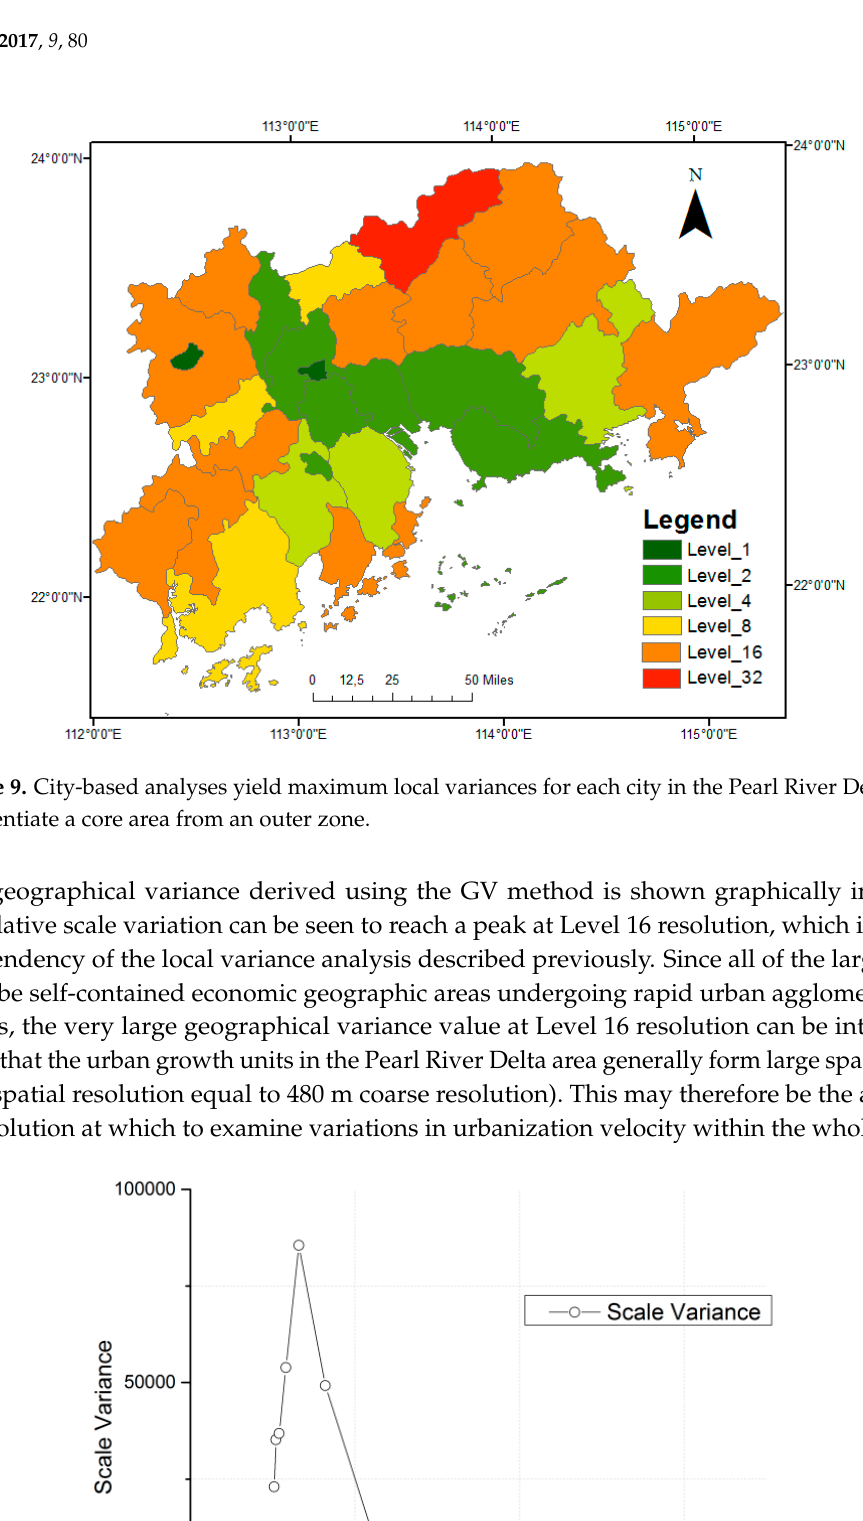
Figure 10. Scale variance graph showing the multi-scale structure of UV analysis results yielding a peak for Level 16 (480 m resolution). See text for explanation.